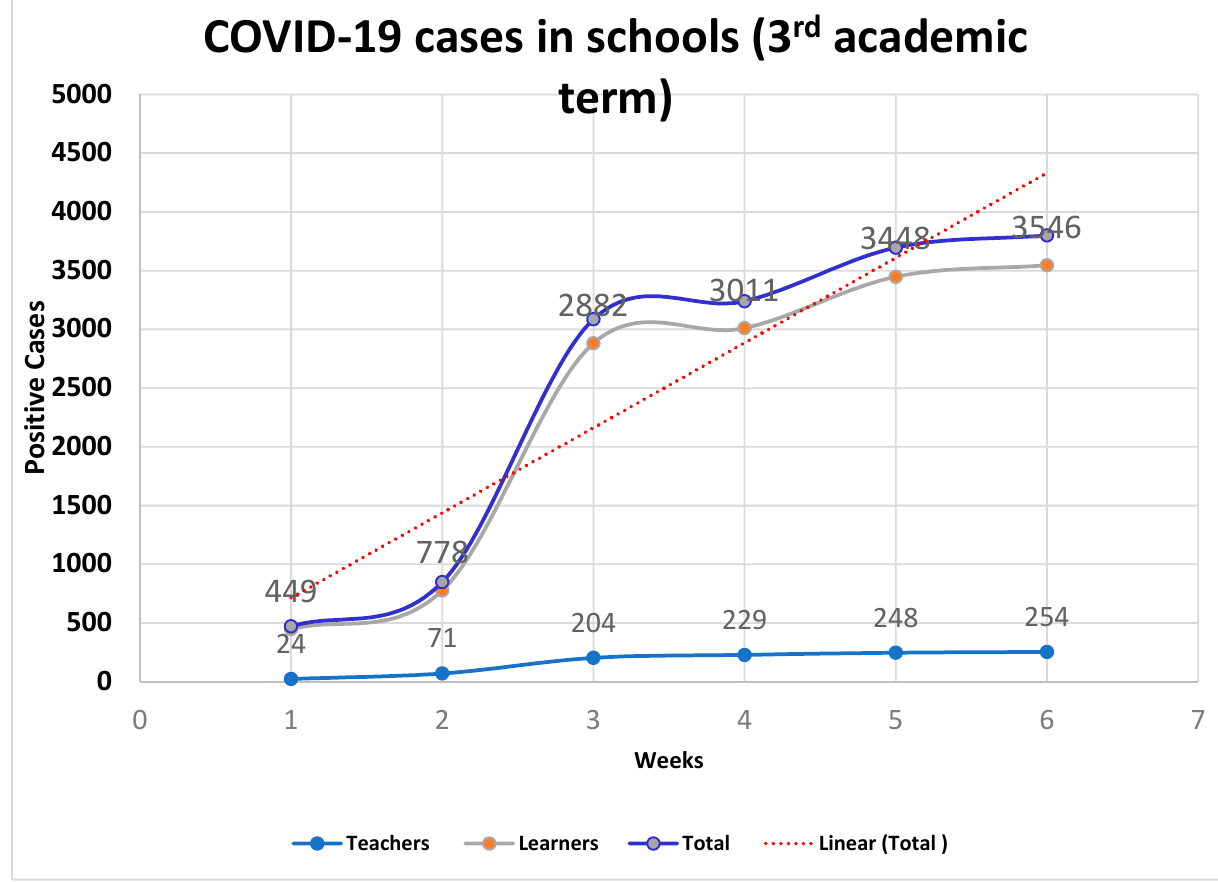
Figure 1. COVID-19 cases in Zimbabwean schools during the third academic term. Source: Ministry of Health and Child Care [14].